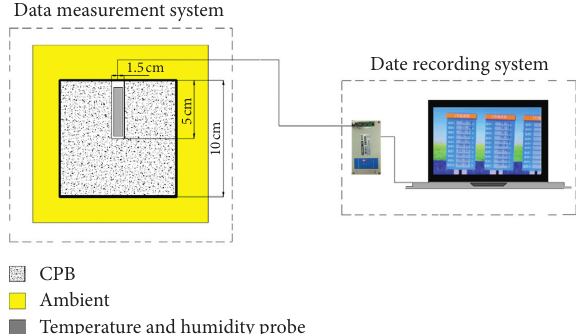
Figure 5: Schematic diagram of the experimental program for